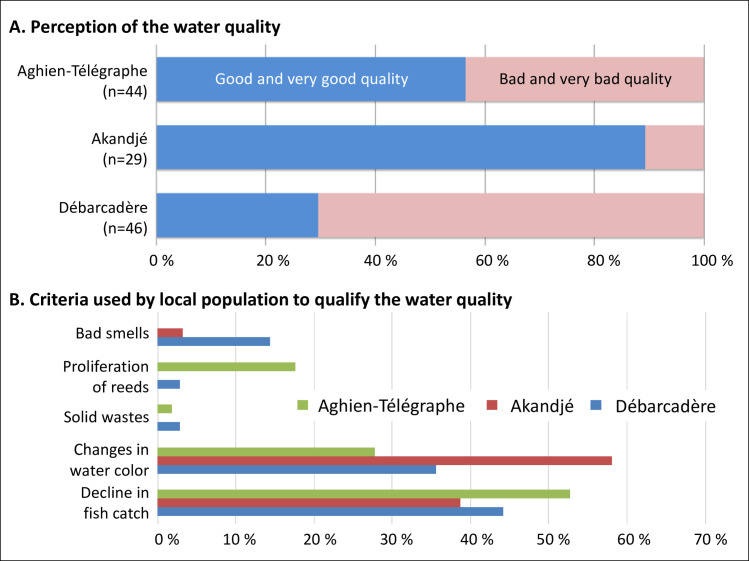
Perception of the water quality in Lagoon Aghien by residents of the three villages (Aghien-Télégraphe, Akandjé, Débarcadère).Respondents were asked (A) how they evaluate the quality of the lagoon using a four-point scale (very good, good, bad, very bad) and (B) which criteria they use for the assessment of the water quality.